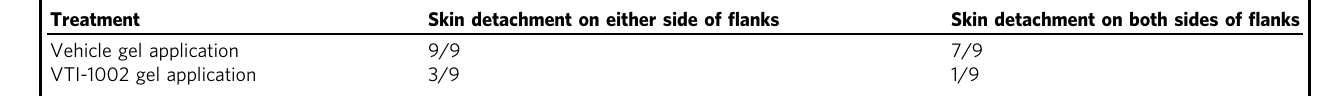
Primary mouse epidermal keratinocytes were isolated from humanized COL17 mouse neonatal skin samples. Brie fl y, skin tissues were processed with 2.4U/ml of